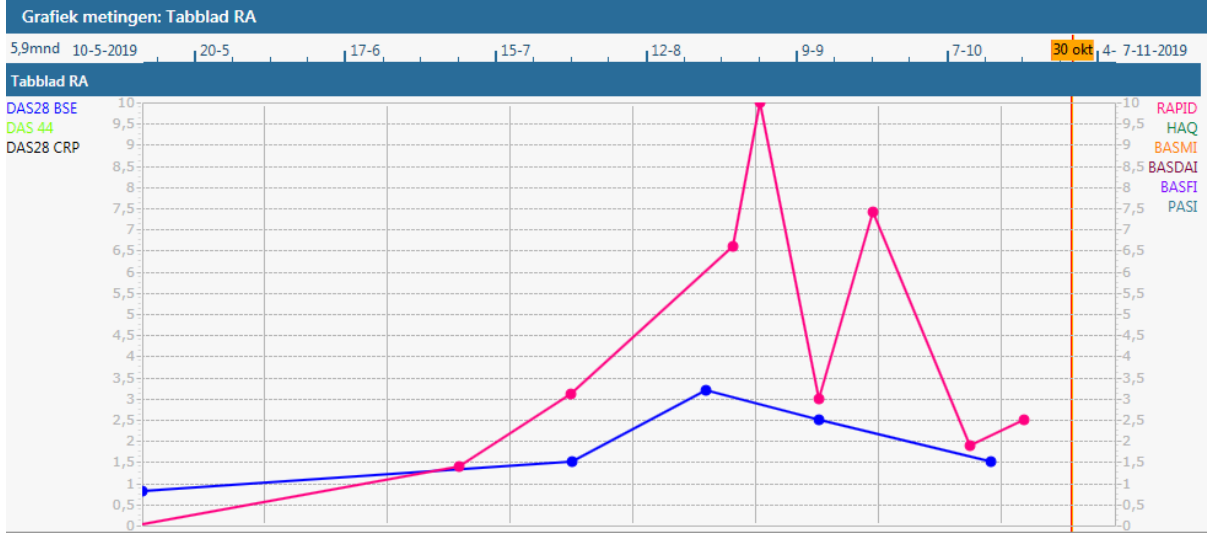
Figure 3. EMR dashboard. The EMR dashboard displays the results collected with the app. The data originate from the EMR itself, where they are stored in real-time after questionnaire completion in the app. The graph displays disease activity over time as measured by the RAPID3 (red) and DAS28 (blue). DAS28: Disease Activity Score 28; EMR: electronic medical record; RAPID3: Routine Assessment of Patient Index Data 3.